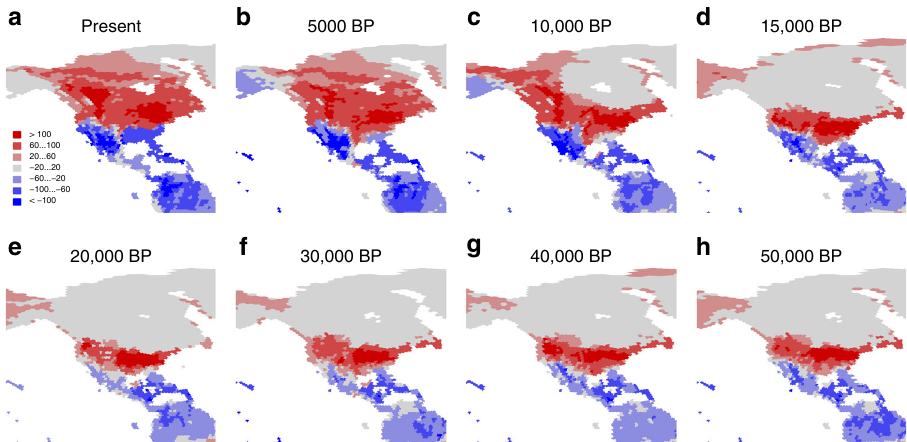
Fig. 4 Fifty-thousand years of predicted seasonal difference in richness due to migration, across the northern Western Hemisphere. The maps a – h show the seasonal difference in avian richness, computed as the richness in breeding migrants minus the richness in non-breeding migrants, for eight time slices between the present and 50,000 years ago. BP: before present. Red colours are regions with avian higher richness during the breeding season; blue colours are regions with higher richness during the non-breeding